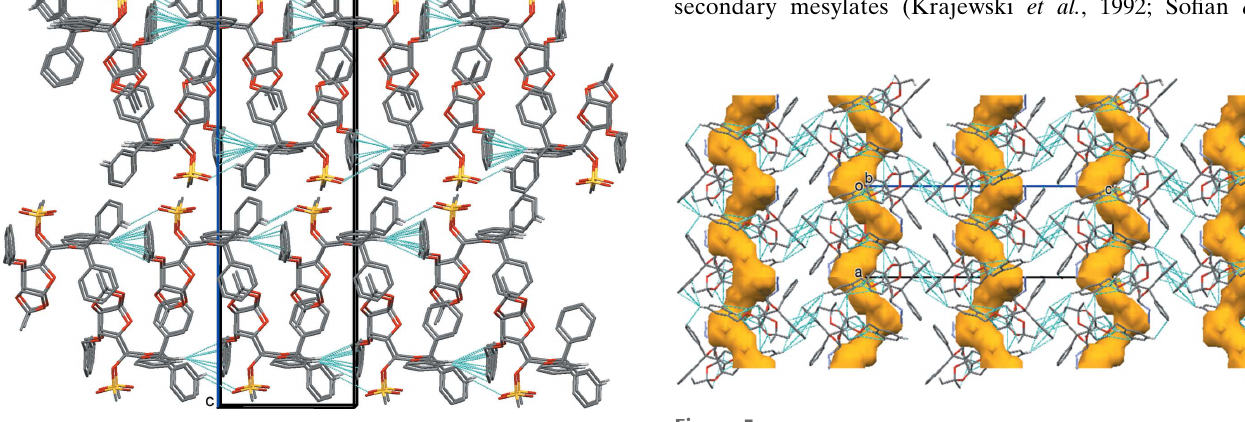
Figure 4 A view along the a axis of the crystal packing of compound 3 . The C— H (cid:2)(cid:2)(cid:2) O and C—H (cid:2)(cid:2)(cid:2) (cid:2) interactions (see Table 1) are shown as dashed lines. For clarity, only the H atoms involved in these interactions have been included.